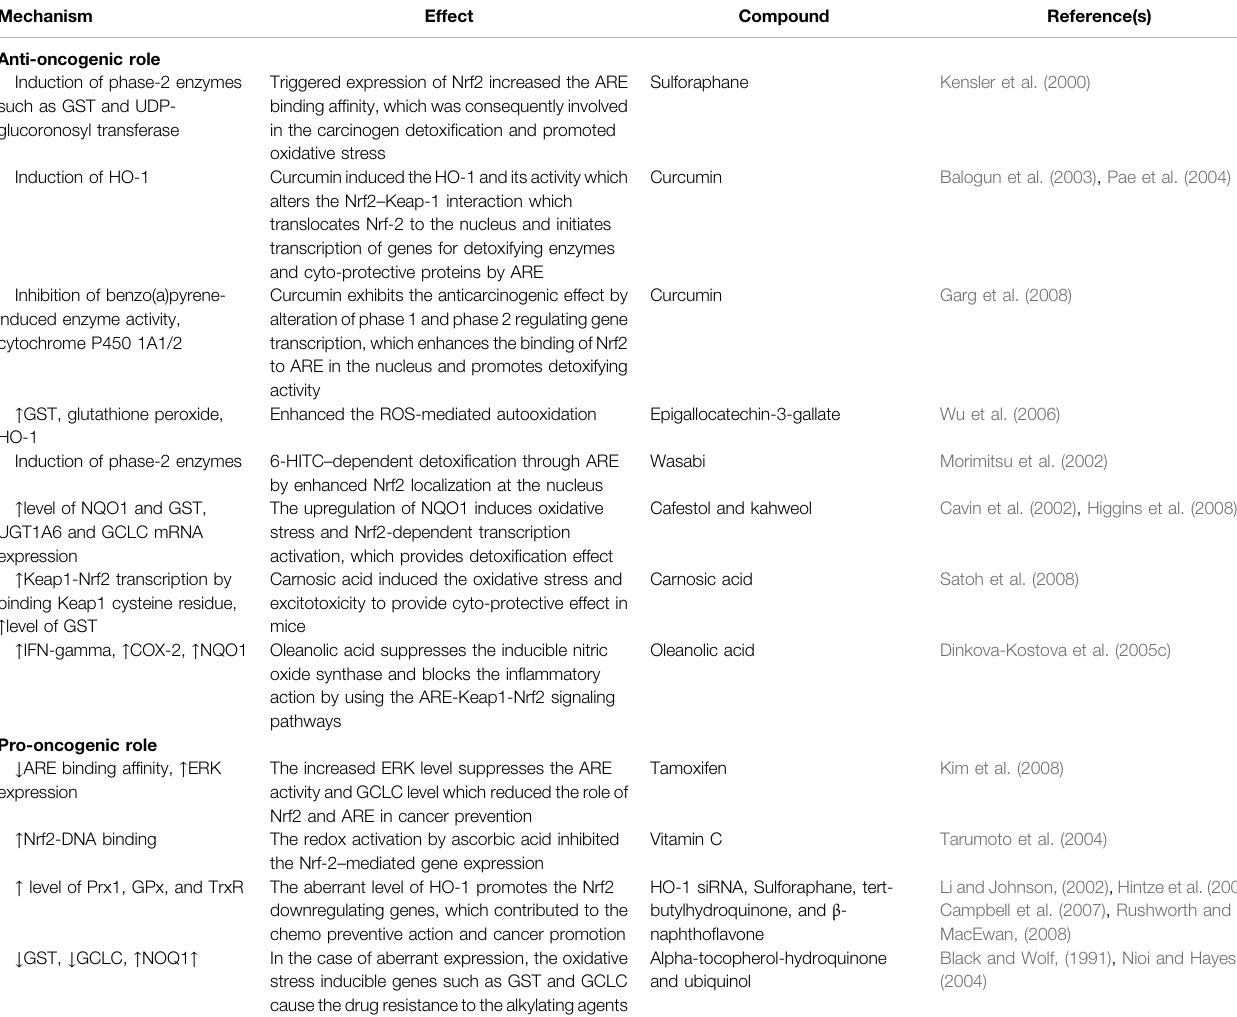
TABLE 2 | Anti-oncogenic and pro-oncogenic mechanisms of Nrf2 with various compounds: in vivo